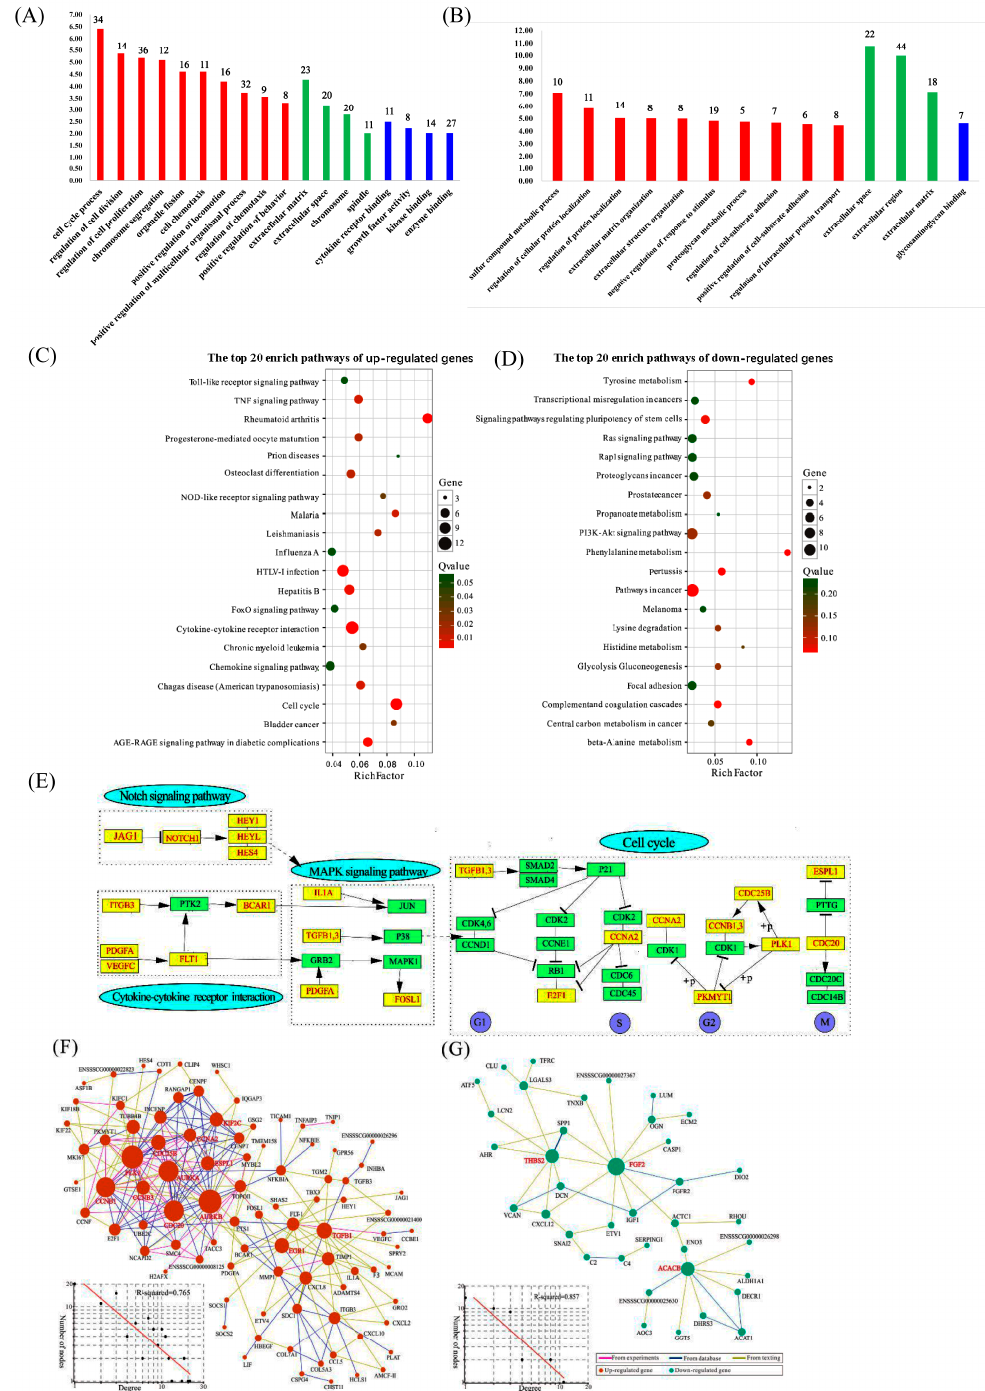
Figure 3. Differential genes functional annotation and interaction in P-N1ICD vs. P-Control. ( A ) Gene Ontology (GO) analysis of upregulated differential genes in proliferation; ( B ) GO analysis of down -regulated DEGs in proliferation; ( C ) Kyoto encyclopedia of genes and genomes (KEGG) analysis of upregulated DEGs in proliferation; ( D ) KEGG analysis of downregulated differential genes in proliferation; ( E ) Up-regulated DEGs in proliferation involve in Notch signaling pathway, Focal adhesion, MAPK signaling pathway and Cell cycle; ( F ) Gene interaction of upregulated DEGs in proliferation; ( G ) Gene interaction of downregulated DEGs in proliferation. Nodes represent genes and edges represent gene-gene interactions. The diameter of each node is proportional to its degree value. This graph was generated using the Cytoscape software. The degree distribution of the network is shown as an inset. The degree distribution follows a power law